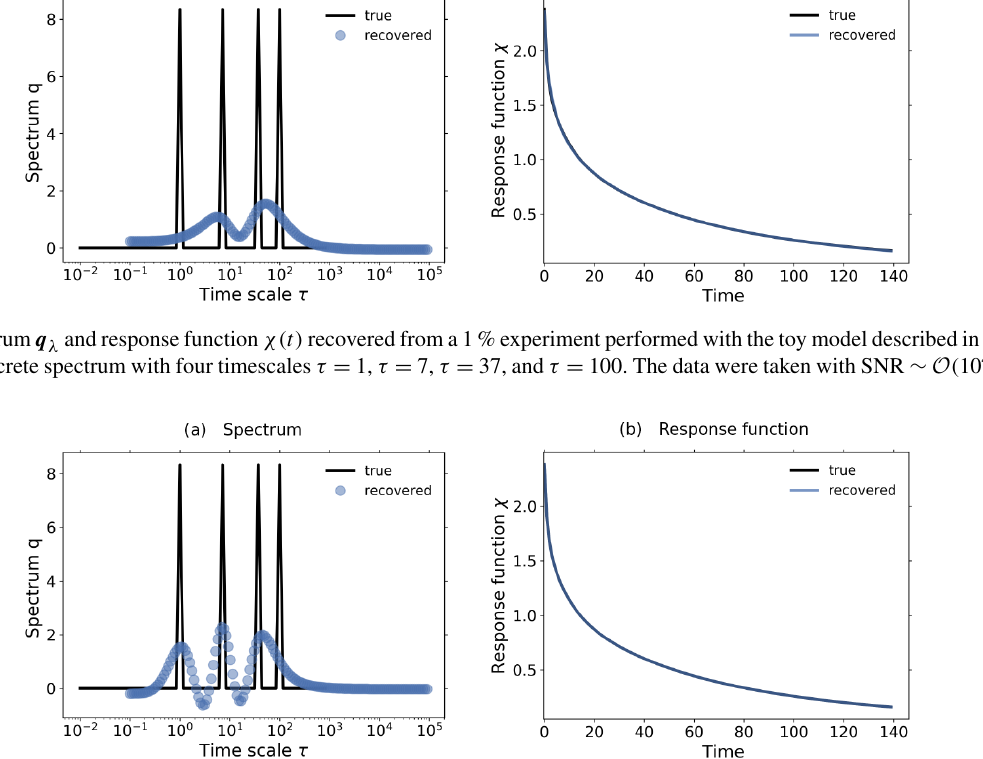
Figure E7. Spectrum q λ and response function χ(t) recovered from a 2 × f 0 experiment performed with the toy model described in Part 1 taking an underlying discrete spectrum with four timescales τ = 1, τ = 7, τ = 37, and τ = 100. The data were taken with SNR ∼ O ( 10 4 ) − O ( 10 5 ) .